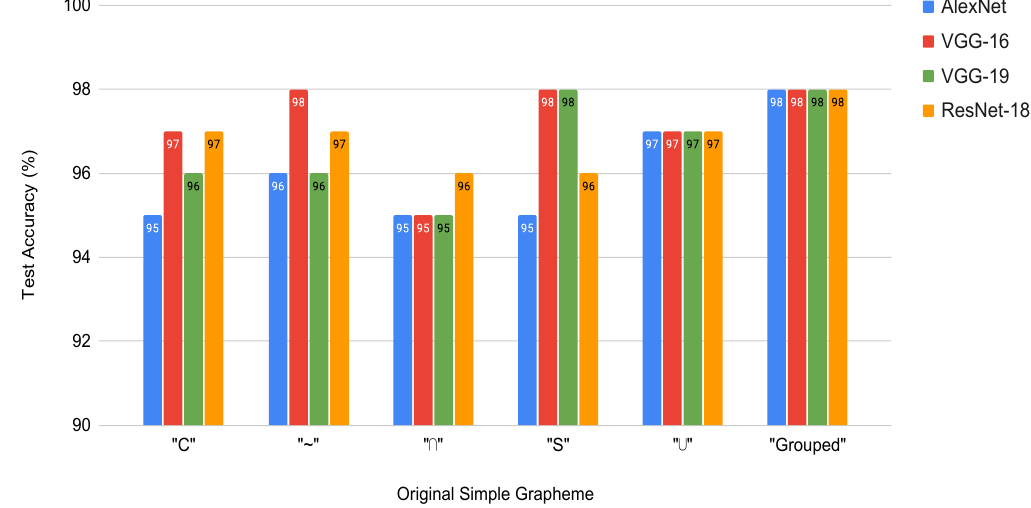
Figure 10. Original Simple Grapheme Test accuracy with AlexNet, VGG-16/VGG-19 and ResNet-18